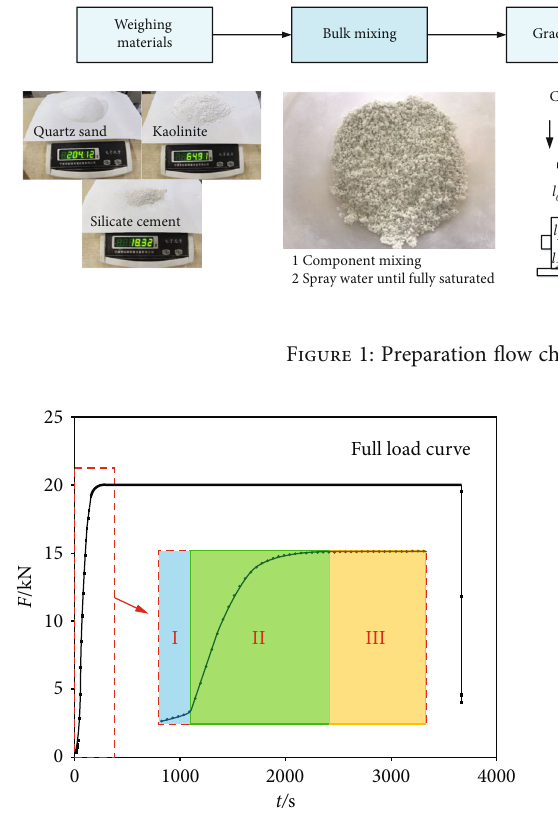
Figure 2: Compression plastic process.